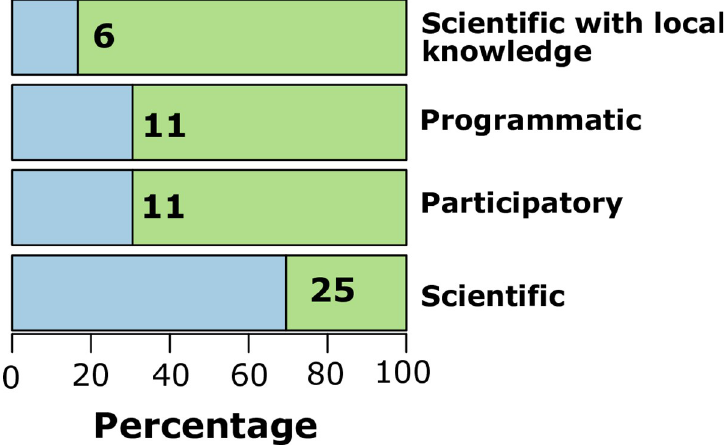
Fig 4. Monitoring types used to measure the success of ecological restoration actions. The total number of projects analyzed was 36.